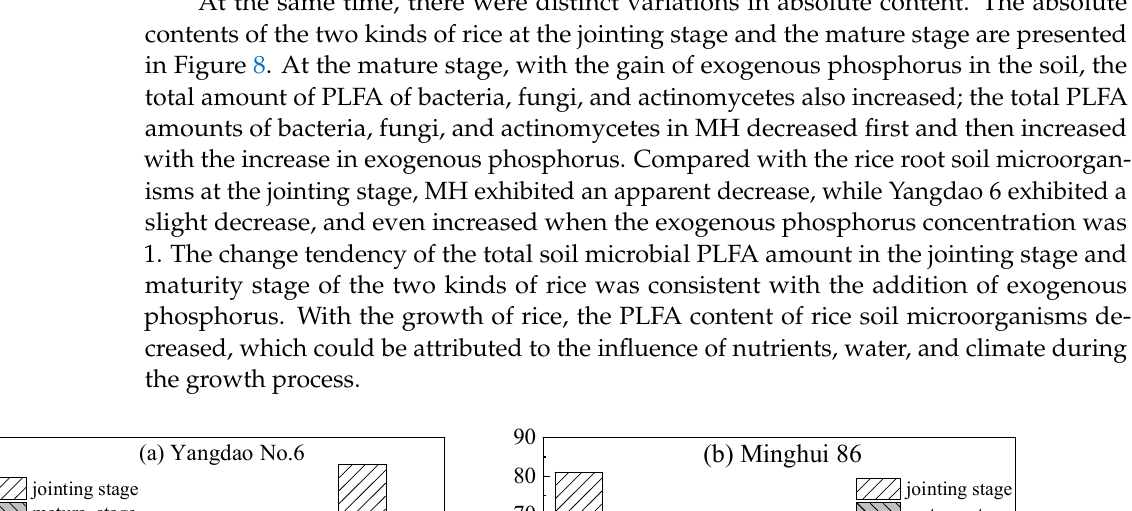
Figure 7. Relative content of rice strains.